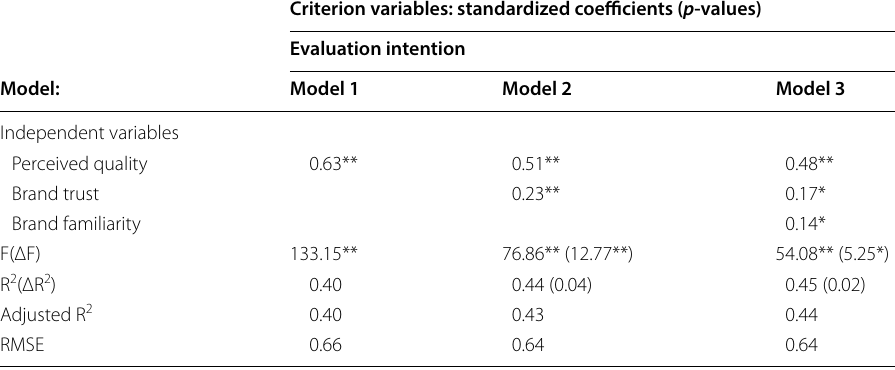
** Significant at p -value < 0.01. * Significant at p -value <